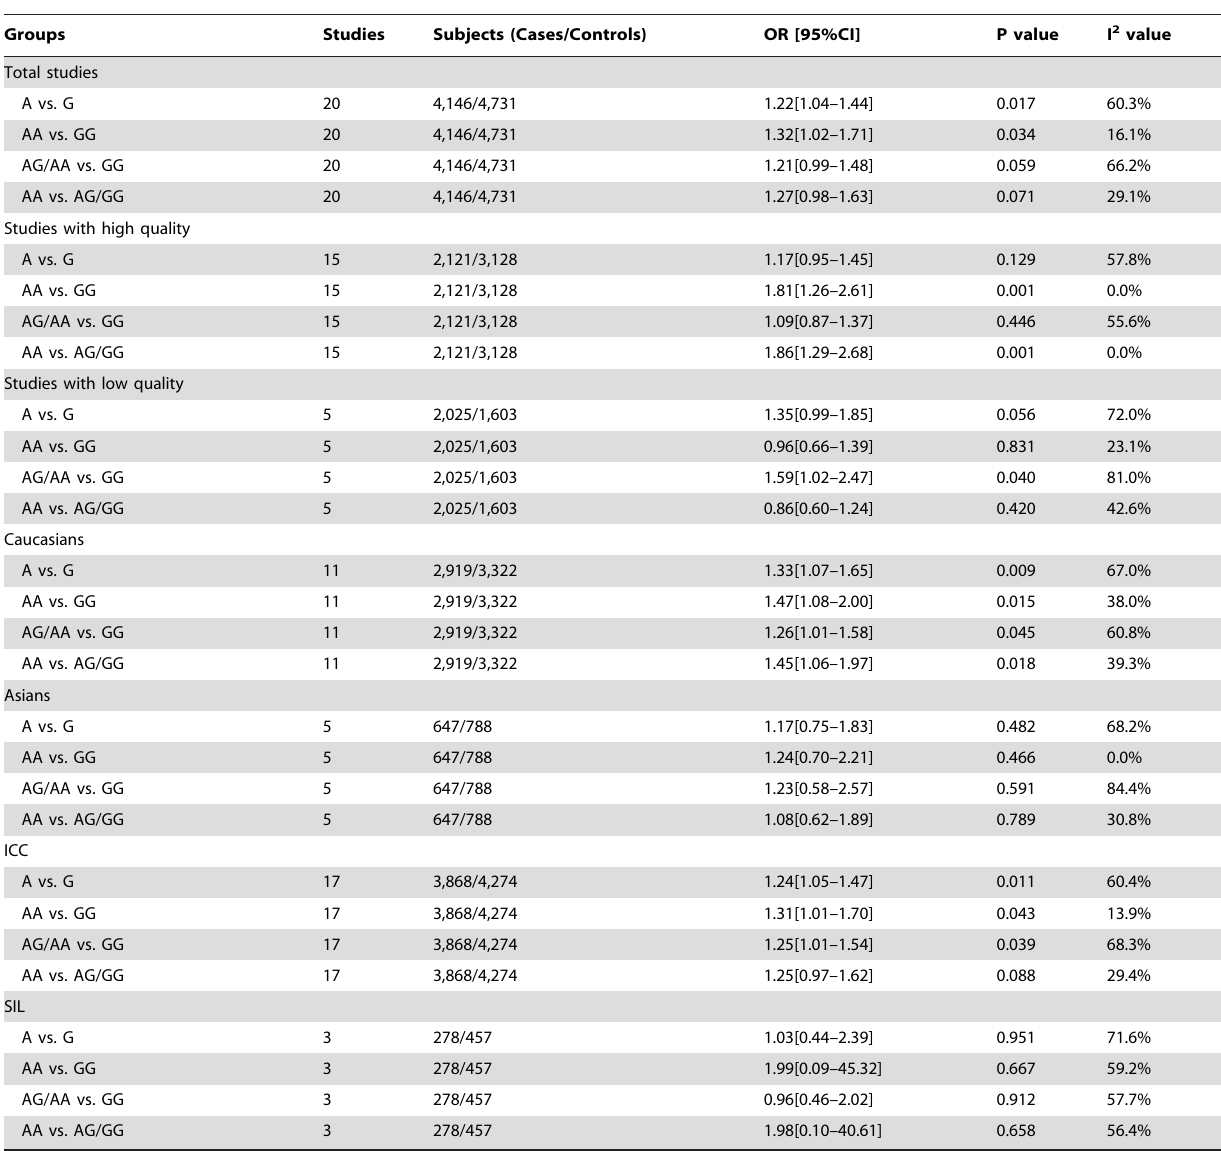
Table 2. Meta-analysis of the association between TNF- a rs1800629 polymorphism and cervical lesions